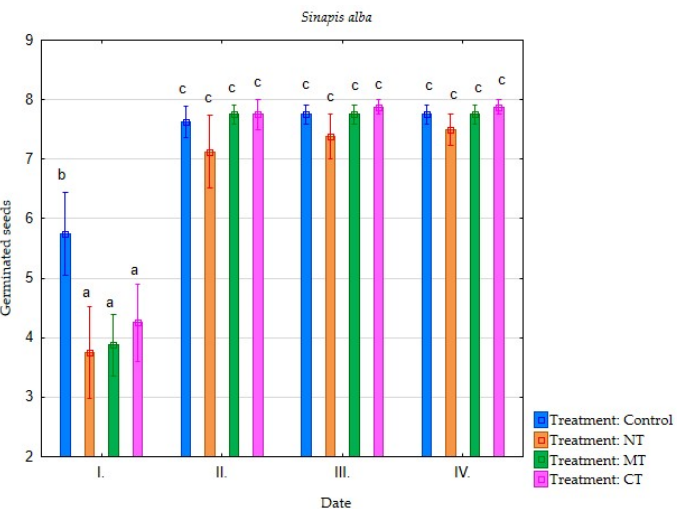
Figure 3. Development of the germination of Sinapis alba caryopses watered with soil leachates from different soil tillage. The results represent the mean of 8 biological replicates ± SE. Identical letters express statistical non-significance between the variants, different letters express statistical significance at a significance level p = 0.05 (Fisher LSD test). The plot shows the mean, the whiskers representing the standard error, values with different letter (a, b, c) differ significantly. Variants of tillage technologies: CT—Conventional tillage with ploughing; MT—Minimum tillagethe; NT—Direct sowing.